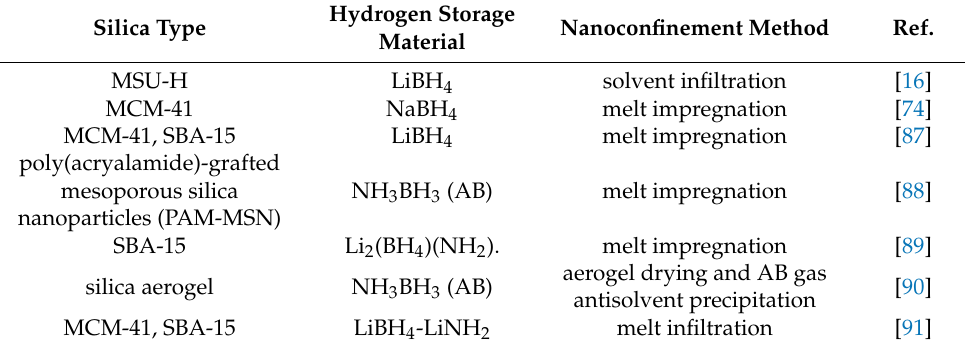
Table 1. Recent progress in silica-based supports for nanoconfined hydrogen